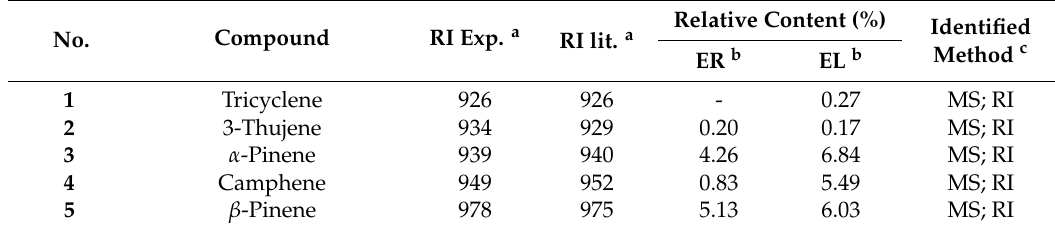
Table 1. Chemical constituents identified from essential oils from roots (ER) and leaves (EL) of Asarum heterotropoides